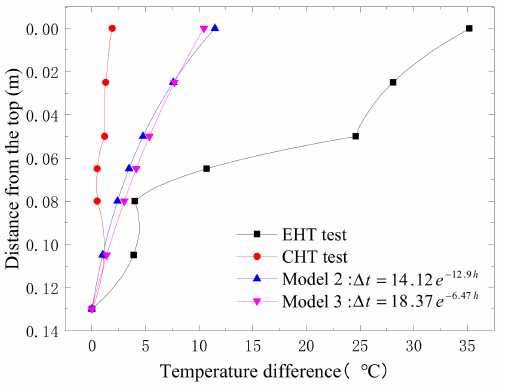
Figure 8. Comparison of the vertical temperature di ff erence